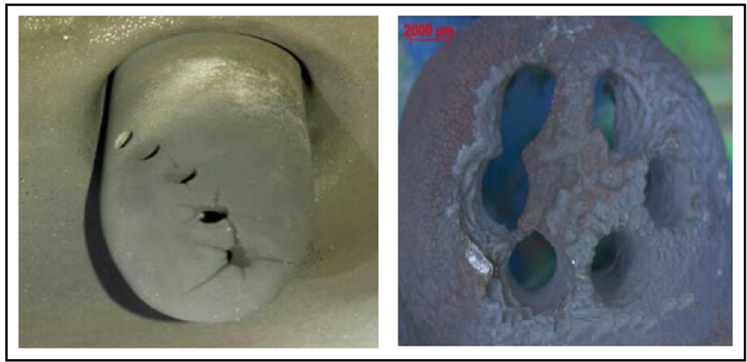
Figure 1. Case of damage to the gas nozzle of a DF engine.